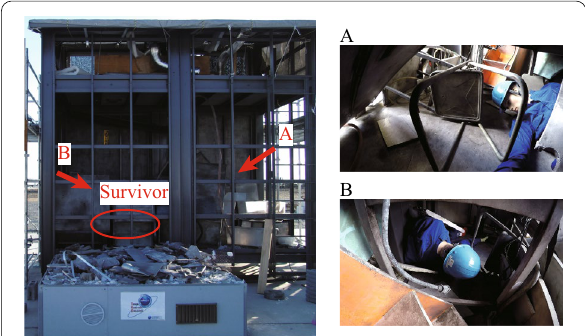
Fig. 13 Photograph of the debris environment at the Fukushima Robot Test Field. This field simulates a situation wherein a factory office has exploded and rubble is